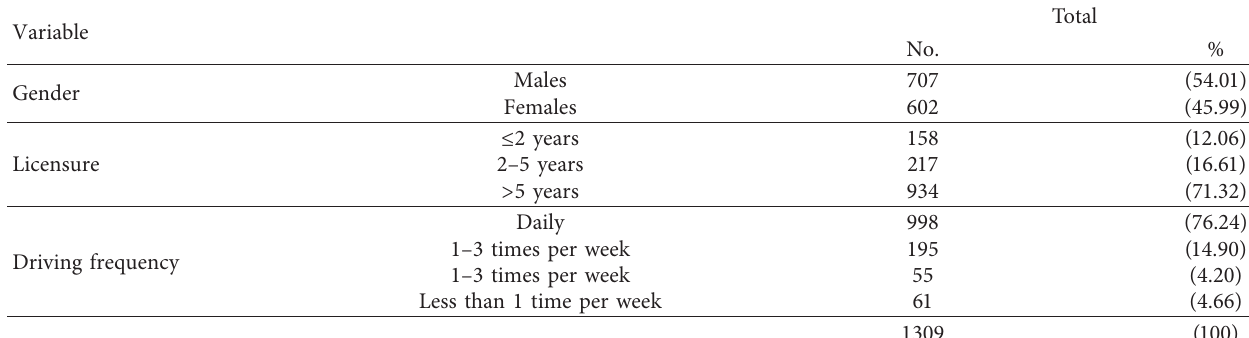
Table 3: Descriptive statistics of the final